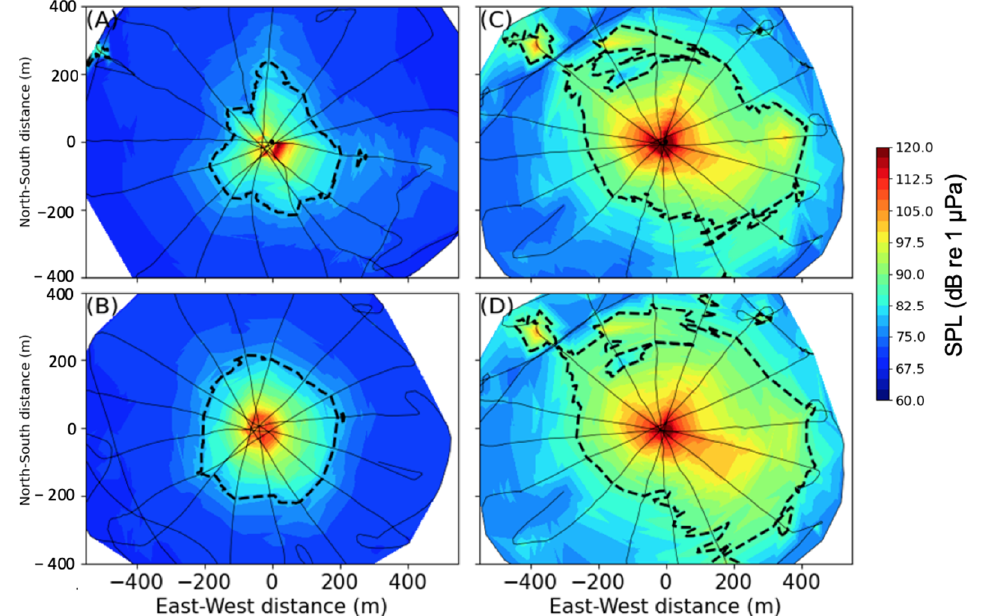
Figure 5. Received sound pressure levels (SPLs) for the 200 kHz signal (198–206 kHz) at ( A ) 5 and ( B ) 30 m and for the 83 kHz signal (80–87 kHz) at ( C ) 5 and ( D ) 30 m water depths from the shallow- water transects (black lines). The black dashed lines show the contours at 40 dB below maximum SPL (maxSPL ) .